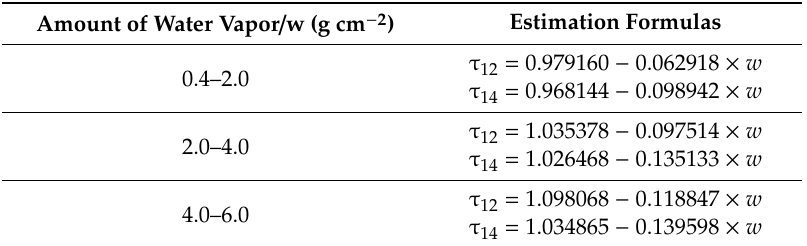
Table 1. Estimation formulas for atmospheric transmittance calculation—ASTER